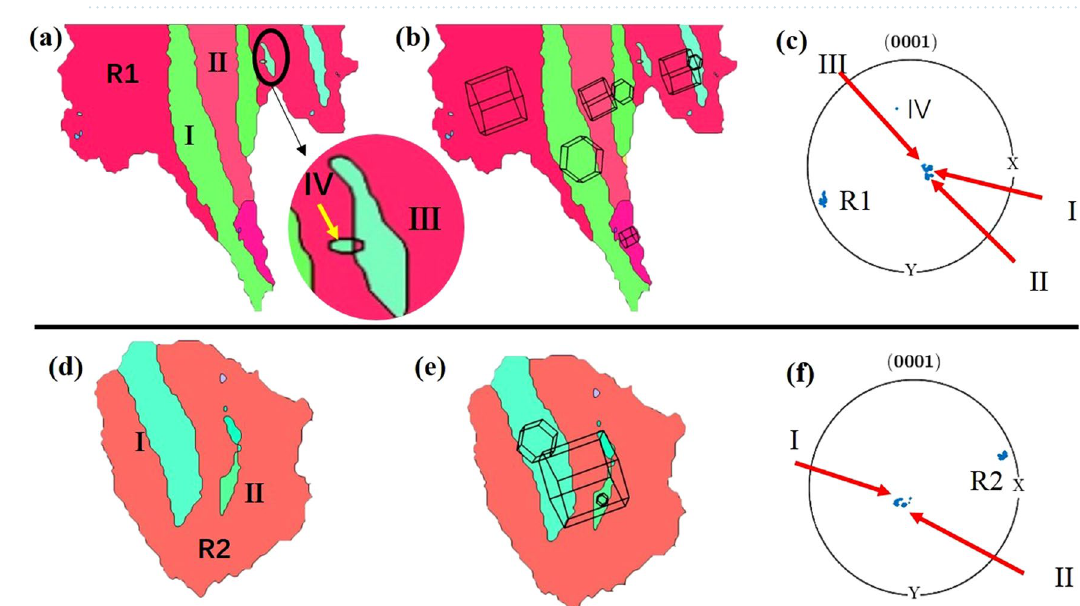
Figure 8. Selected grain regions R1, R2 in the Mg–2Y–0.6Nd–0.6Zr alloy rolled at room temperature. ( a ), ( d ) Inverse pole figure maps, ( b ), ( e ) three-dimensional stereoscopic orientation diagrams of individual grains, and their twins are shown in the (0001) pole figures in ( c ), ( f